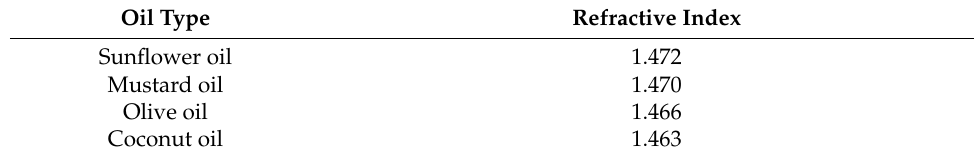
Table 1. Refractive indices of different oil samples under test at room temperature [35].